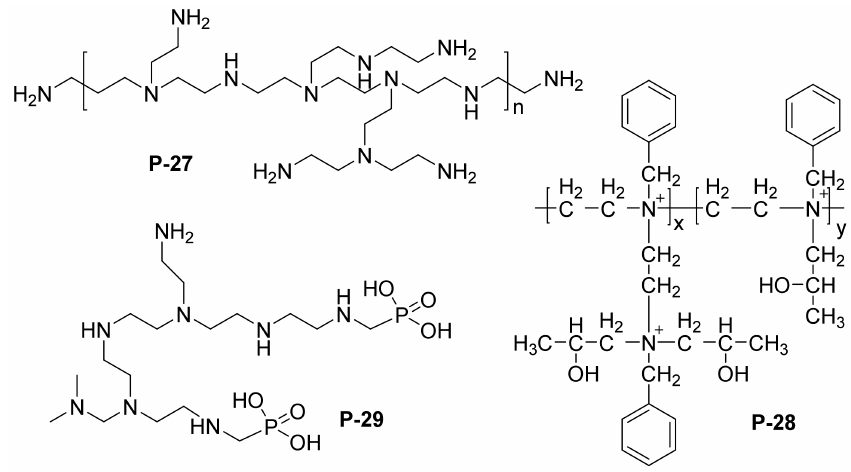
Figure 9. Typical chemical structures of PEI-based nitrogen-containing polymeric inhibitors. PEI can also be used to form hybrids with inorganic material, such as grapheme oxide (GO), to further improve the inhibition performance. As shown in Figure 10, Quraishi et al. [73] modified GO with PEI via facile amidation and investigated its corrosion inhibi- tion of carbon steel in a solution of 15% HCl. According to the weight loss experiment, the PEI-GO alone provided a high corrosion inhibition efficiency of 88.2% at a temperature of 65 ◦ C. Moreover, KI can further increase IE to 95.8% due to their synergistic effect.